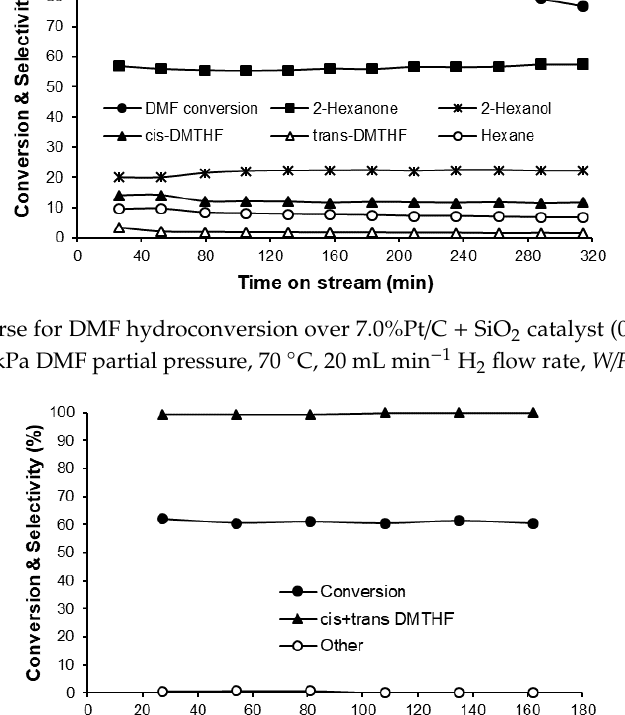
Figure 2. Time course for DMF hydrogenation over 7.8%Pd / C + SiO 2 catalyst (0.20 g total weight, 0.6 mg Pd / C) at 1.6 kPa DMF partial pressure, 70 ◦ C, 40 mL min − 1 H 2 flow rate, W / F = 0.38 g · h · mol − 1